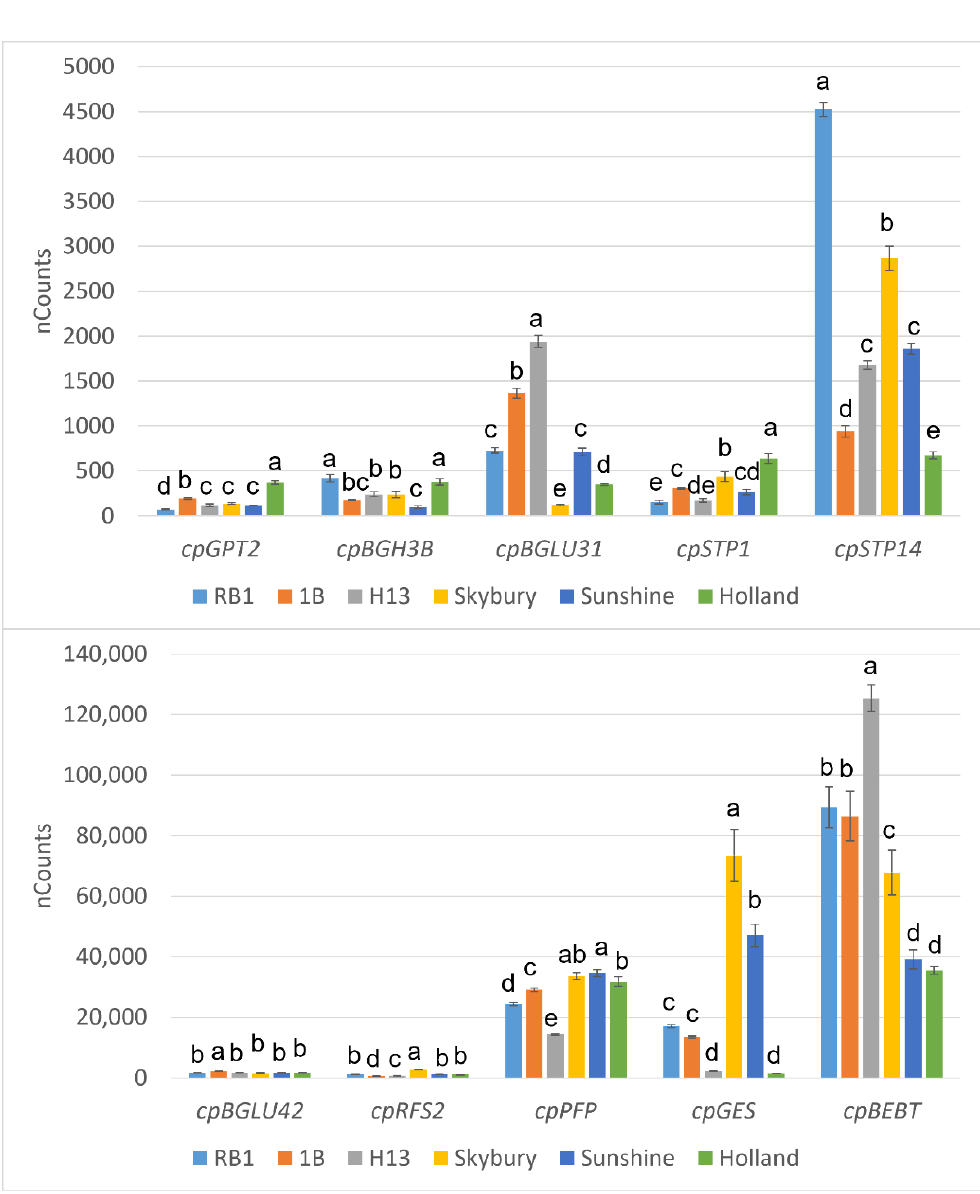
Figure 3. Expression levels of flavour-related genes in papaya varieties based on NanoString anal- ysis. Different letters (a – c) indicate significant differences detected between varieties by Tukey ’ s honestly significant difference test, p < 0.05.